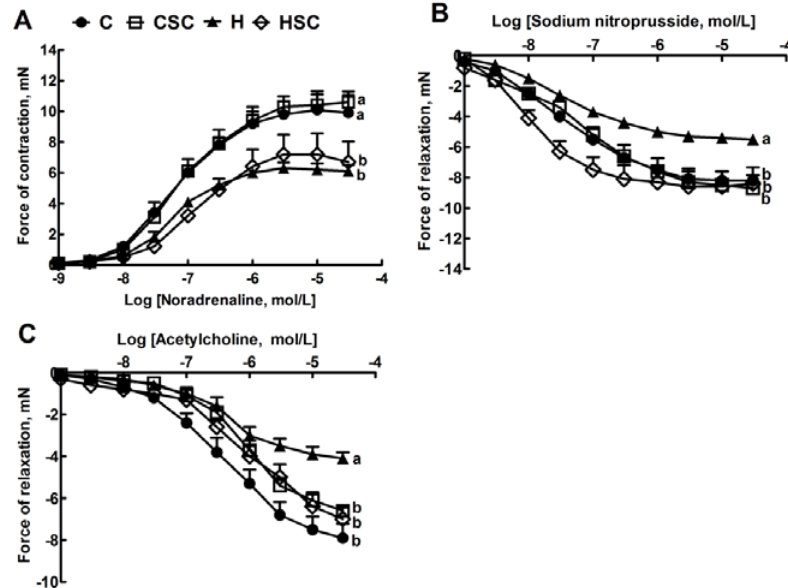
Figure 3. Effect of microalgae mixture treatment on noradrenaline-induced contraction ( A ), sodium nitroprusside-induced relaxation ( B ); and acetylcholine-induced relaxation ( C ) in thoracic aortic preparations from C, CSC, H and HSC rats. Values are mean ± SEM, n = 9–10. Endpoints means without a common letter differ significantly at p < 0.05. C, corn starch-fed rats; CSC, corn starch rats treated with Scenedesmus dimorphus + Schroederiella